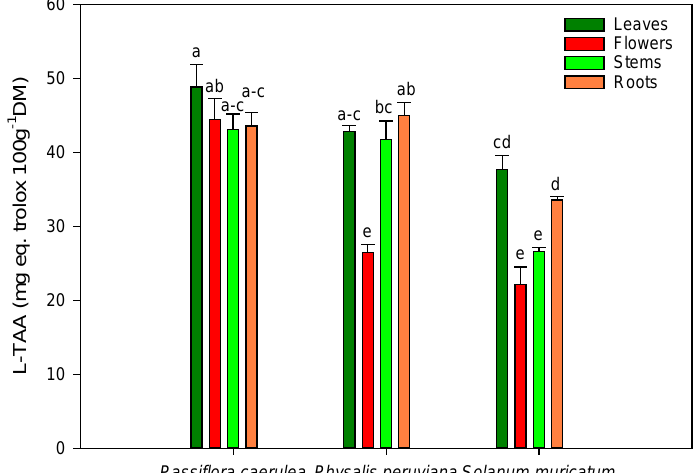
Figure 2. Antioxidant activity of the different parts of Passiflora caerulea L., Physalis peruviana L. and Solanum muricatum Aiton in the lipophilic soluble phase. Different letters on the bars indicate significant differences at a p < 0.05 level of probability. Data are the mean ± standard error (SE).